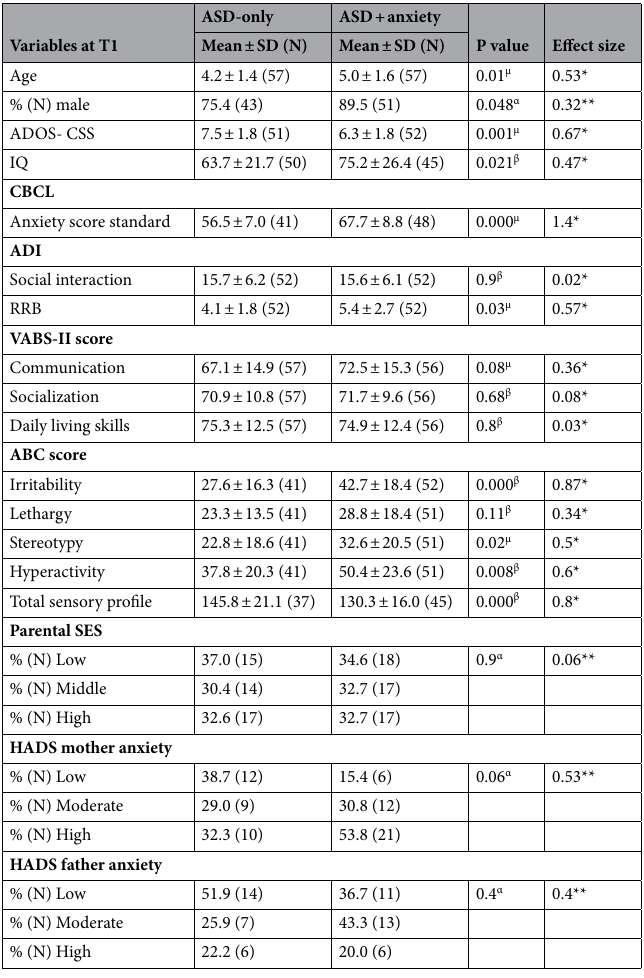
Table 2. Intergroup comparisons of clinical characteristics at T1 (N = 114). α X 2 test; β Student t test; µ